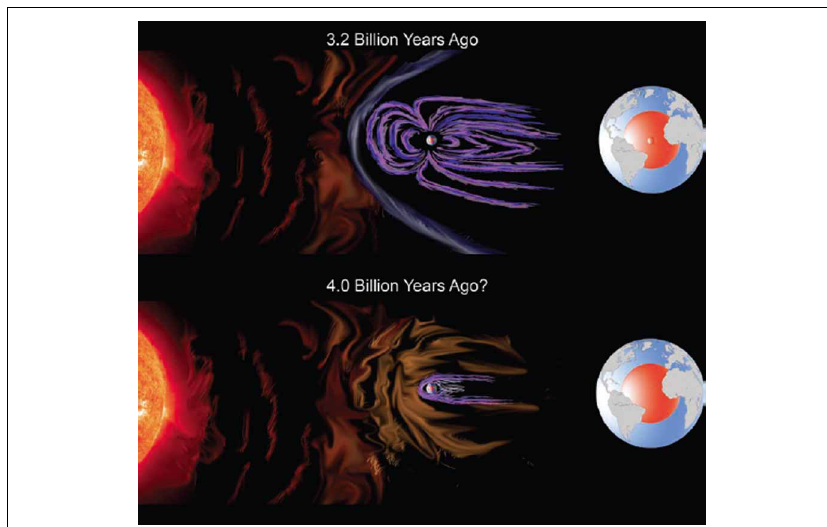
FIGURE 1 | Figure from Tarduno (2009) illustrating the presence of a geomagnetic field at 3.2Ga based on single crystal absolute paleointensity measurements. Hypotheses based on lunar geochemistry and cooling of the ancient magma ocean suggest no geomagnetic field or a very weak one at 4.0Ga that would have made the Earth’s atmosphere vulnerable to erosion by the solar wind. Diagrams on the right show the outer core and the growth of a small inner core at 3.2Ga important for a robust geomagnetic